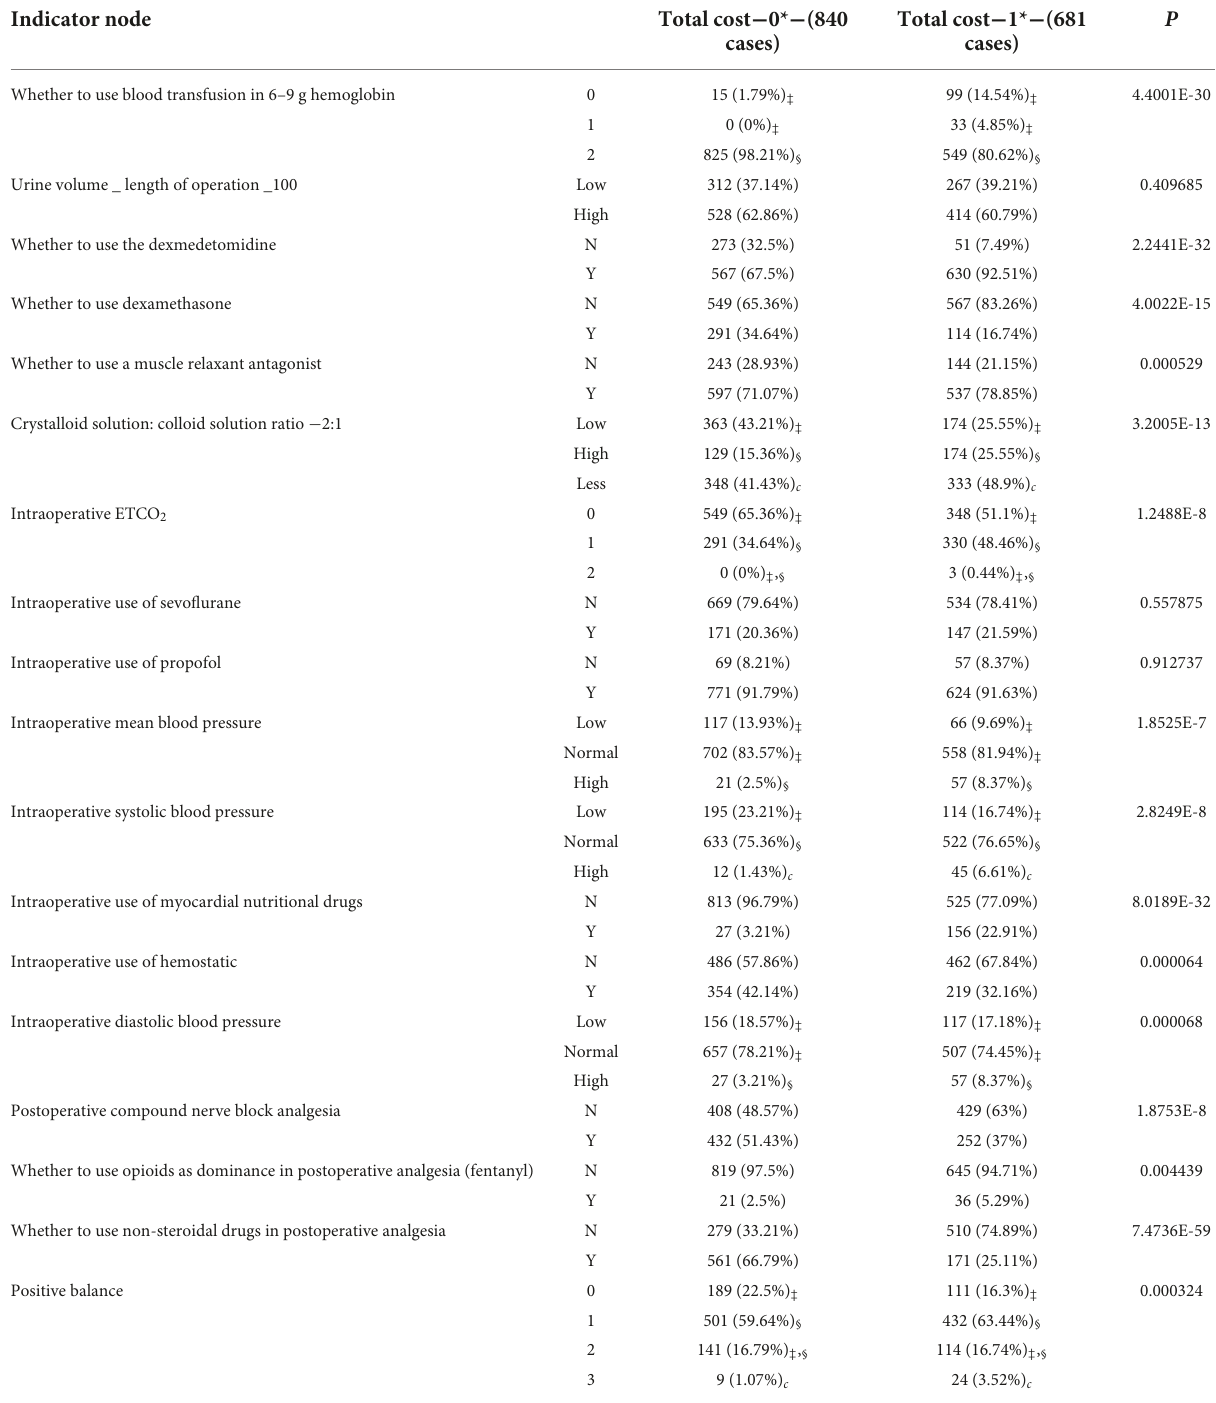
TABLE 4 The influence of Bayesian indicator nodes on the total